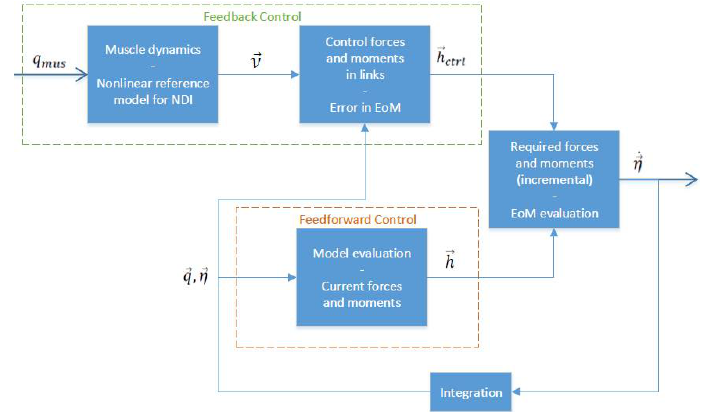
Figure 3. Structure of feedforward-feedback NDI control approach with nonlinear reference model for the MBS ski jumper OC